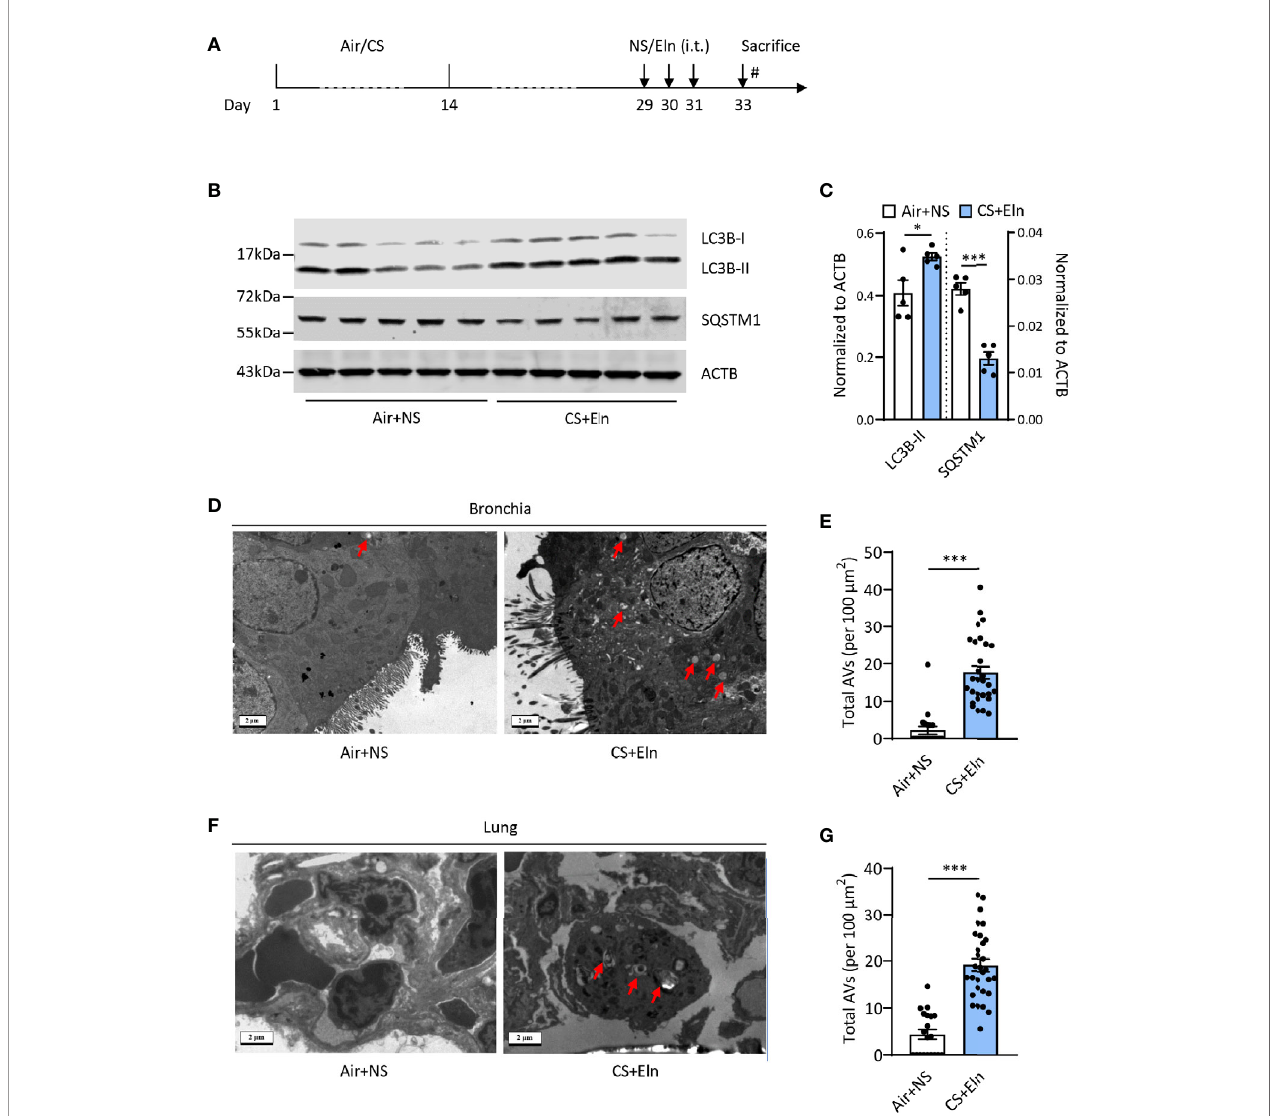
FIGURE 1 | CS exposure following elastin challenge elicits autophagy in mouse lung tissues. (A) Experimental outline. Mice were exposed to CS or room air for 2 weeks and were hosted at room air for another 2 weeks. Mice were then challenged with elastin peptide (Eln, 100 m g) or normal saline (NS) intratracheally (i.t.) for 3 times at day 29, 30, and 31, and were sacri fi ced 48 h after the last elastin challenge. (B) Representative immunoblots and (C) semi-quanti fi cation of LC3B and SQSTM1 in lung tissues of CS+Eln mouse models, ACTB serves as a loading control. (D, F) TEM images (n = 20 images for Air+NS group and n = 30 images for CS+Eln group) and (E, G) semi-quanti fi ed level of autophagic vacuoles in isolated mouse bronchus and lung tissue respectively. Red arrowheads denoted autophagic vacuoles. Scale bar = 2 m m. Data are presented as mean ± s.e.m. Differences between two groups were identi fi ed using the Student t-test * p < 0.05, *** p <